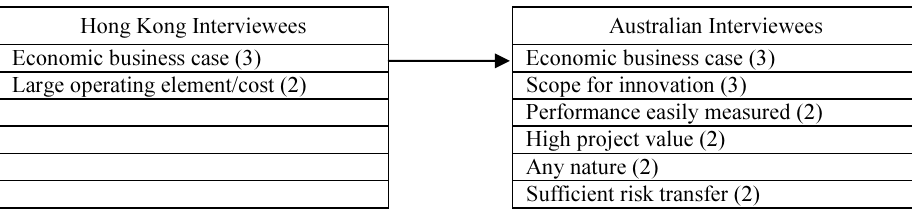
Table 8. Question 3 – Which type of project do you feel is best suited to use